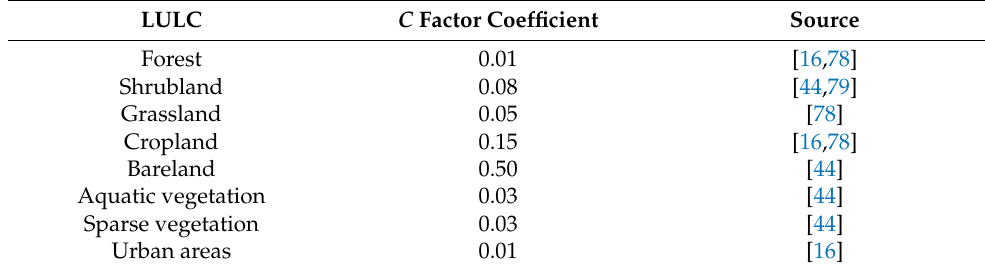
Table 3. C factor values for different land uses in Kenya compiled from published